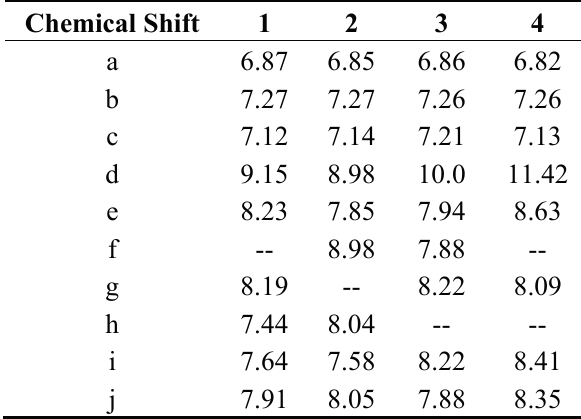
Table 1. Chemical shift of hydrogen atoms in the studied hydrazones.